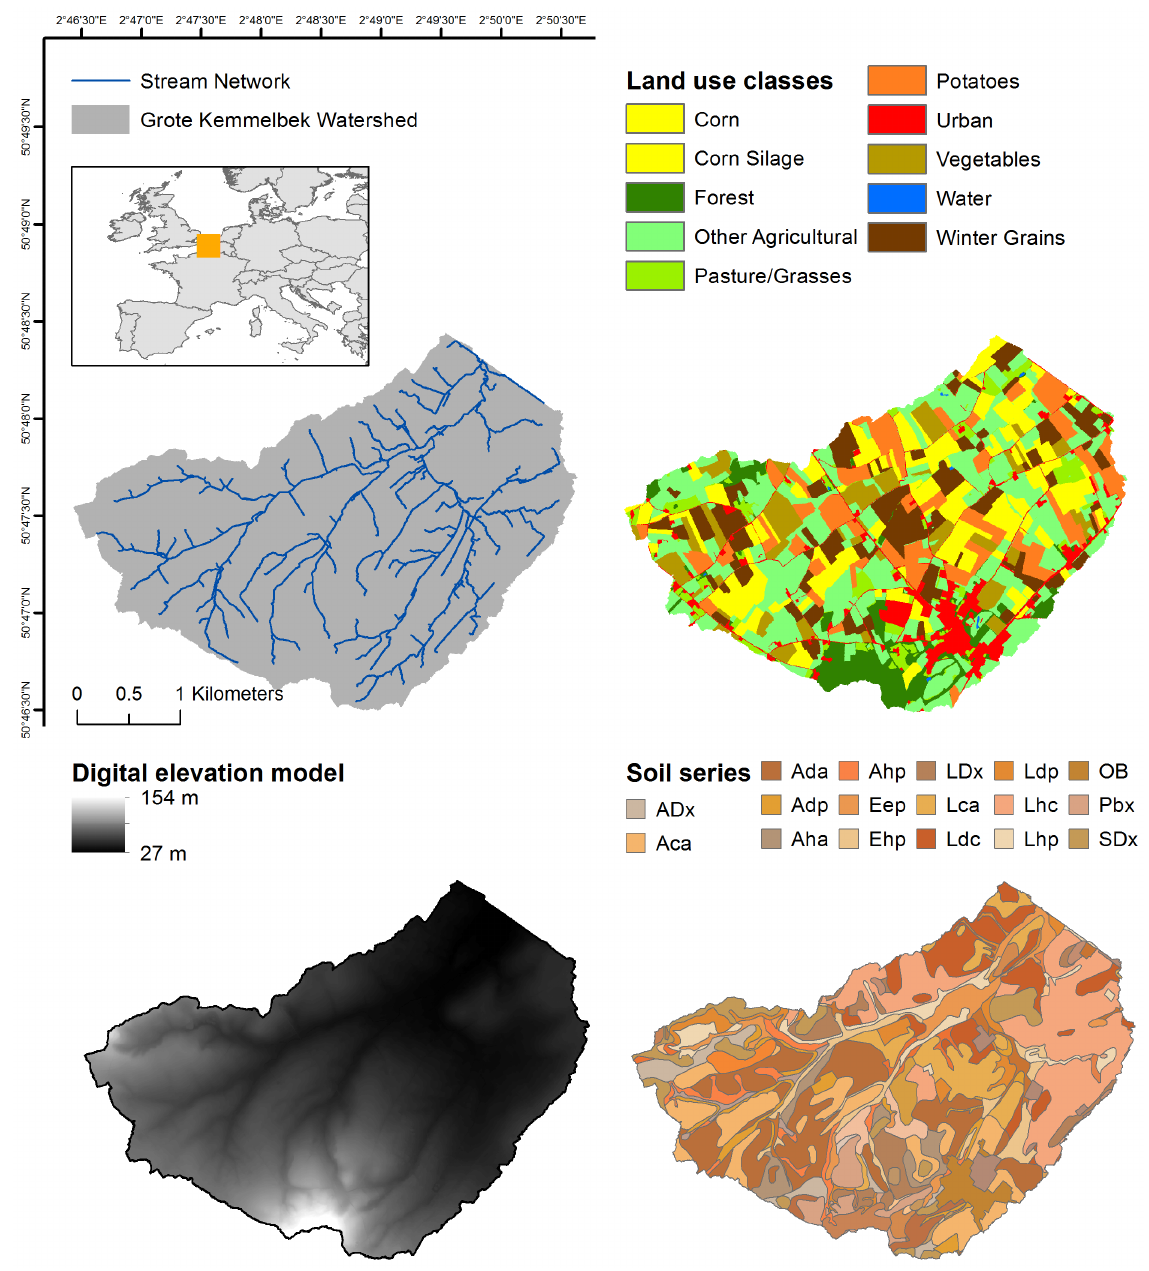
Figure 1. Overview of the Grote Kemmelbek catchment in the Flanders region of Belgium, its stream network, digital elevation model, and land use and soil maps (only soil types with an area greater than 2% of the watershed are shown in the legend and the corresponding soil series codes can be found in [18]).